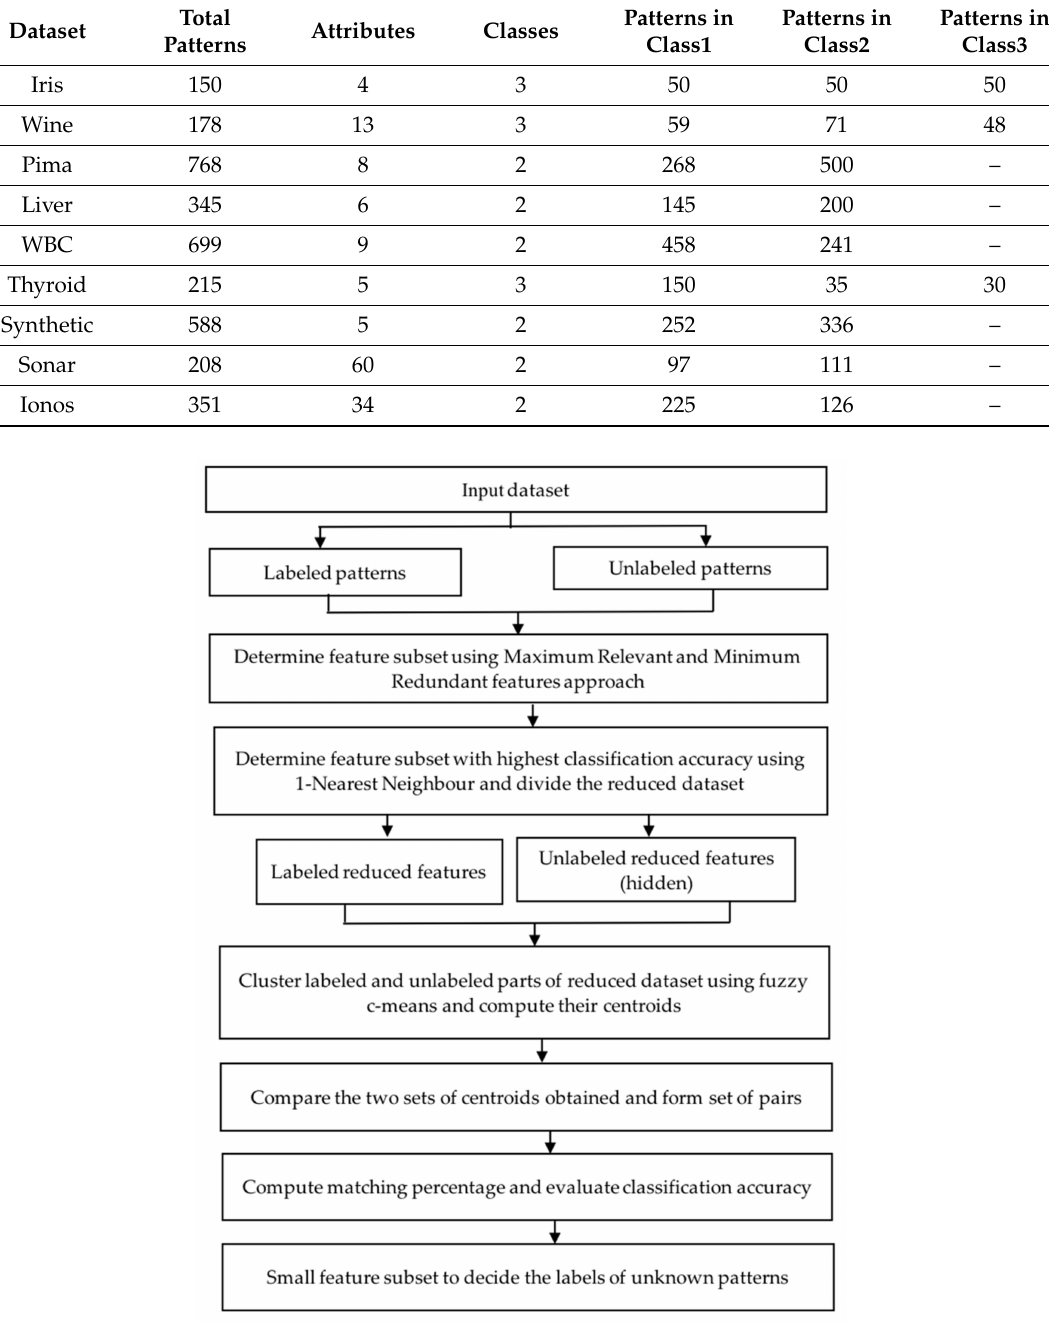
Figure 1. The flow diagram of the proposed